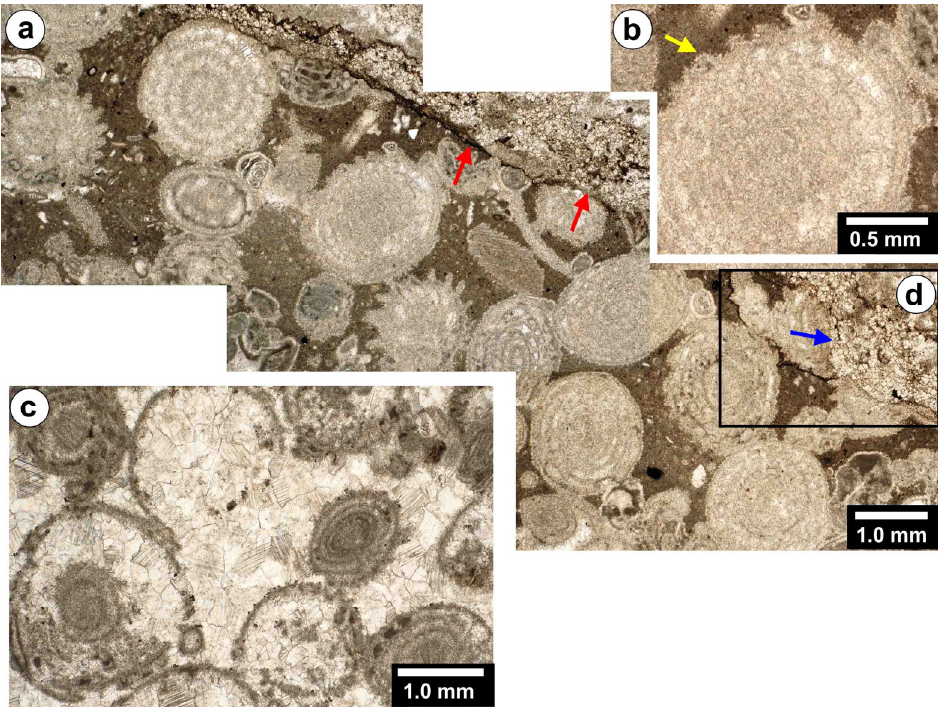
Figure 4 . Further views of the upper Permian limestones from Langbai site in Guizhou Province, China, shown in Figure 3d. ( a ) Montage showing that most of the erosion surface coincides with a stylolite (red arrows), and only in a small area in the lower right is the erosion surface clearly displayed (blue arrow), enlarged in ( d ); ( b ) Enlargement of a foraminiferan in the centre of ( a ), showing marginal dissolution of the test (yellow arrow); the intergranular space is filled with micrite after dissolution; ( c ) A portion of the same limestone a few cm below a, showing a foraminiferan grainstone, where foraminifera are substantially recrystallized; ( d ) Enlargement of the right hand portion of ( a ), showing a complex pattern of erosion surface (blue arrows) and stylolites (red arrows), illustrating the detailed nature of the problem of pressure solution in determining the precise nature of grain boundaries and erosion surface contacts. Such problems have significant implications for identifying surfaces that may have been affected by sea-floor dissolution due to ocean acidification, discussed in the text. Small dolomite rhombs replaced some of the depositional